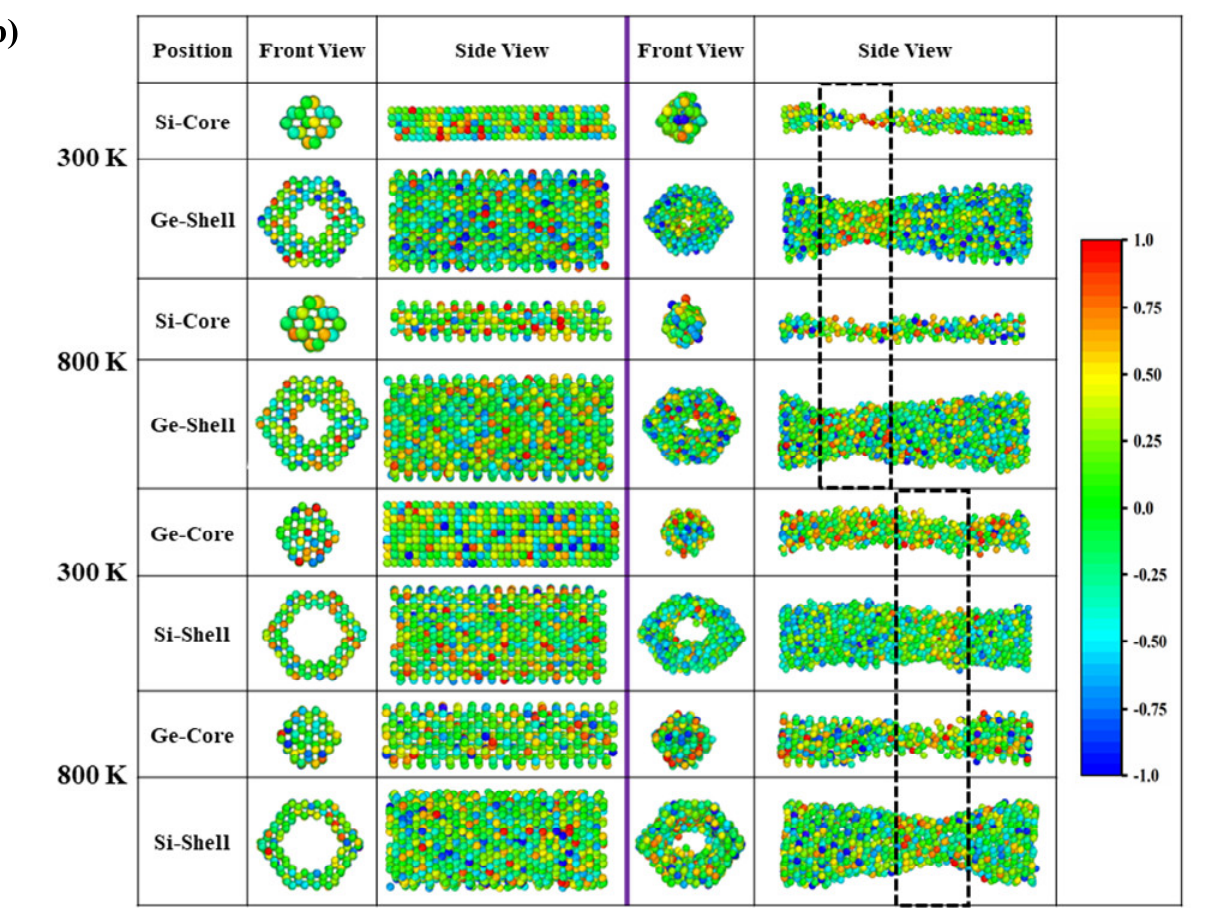
Figure 6. ( a ) The Lode–Nadai parameter distributions, where the dark grey and light purple lines correspond to 300 K, and the dark and dark purple lines represent 800 K: ( Left ) Ge@Si_NW1 and ( Right ) Si@Ge _NW2 and ( b ) Lode–Nadai structure distribution map during stretch processes at 300 K and 800 K. The different colors on the atoms (i) represent different Lode–Nadai parameters: ( Left ) small strain, ε = 0.02 and ( Right ) larger strain, corresponding to the strain in ( a